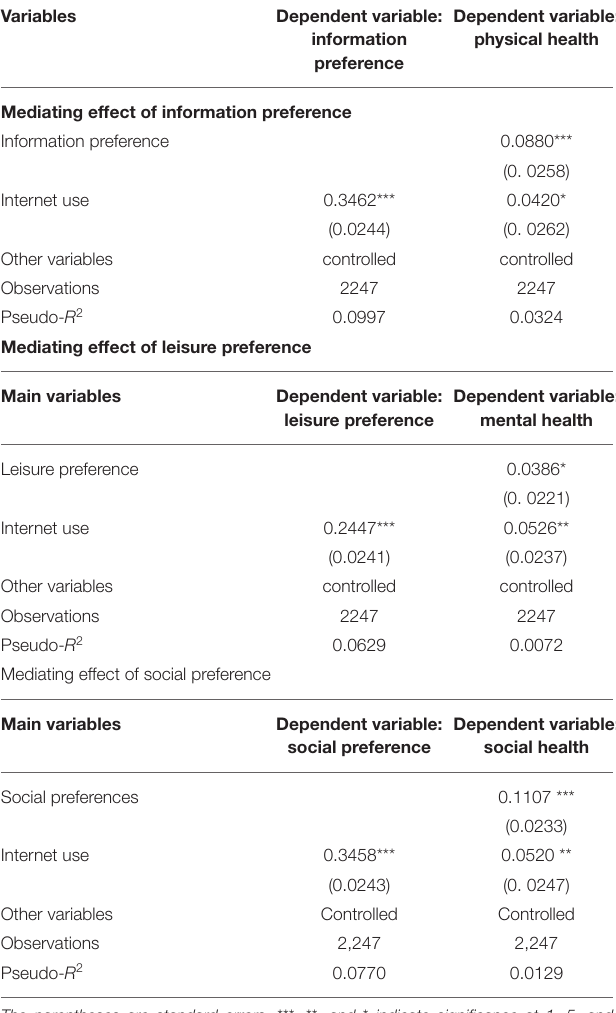
TABLE 7 | Test results of mediating